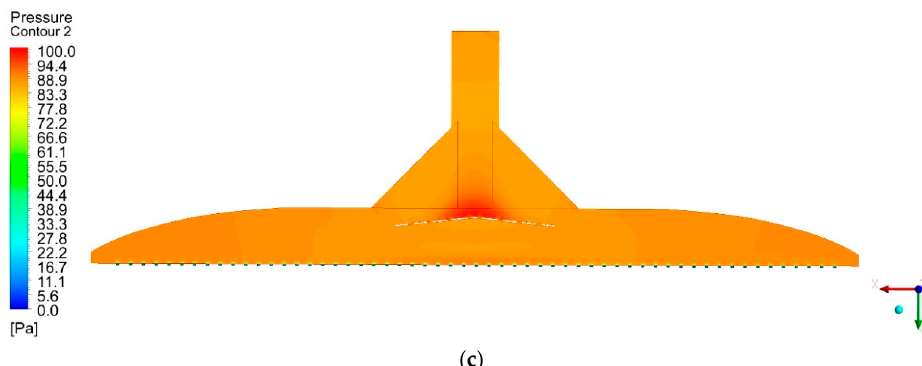
Figure 7. Pressure contours at the middle plane of the three new gas torches: ( a ) model 1; ( b ) model 2; ( c ) model 3.